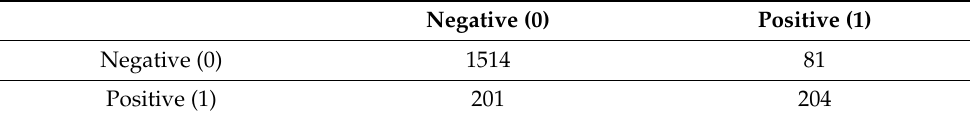
Table 9. Confusion matrix.